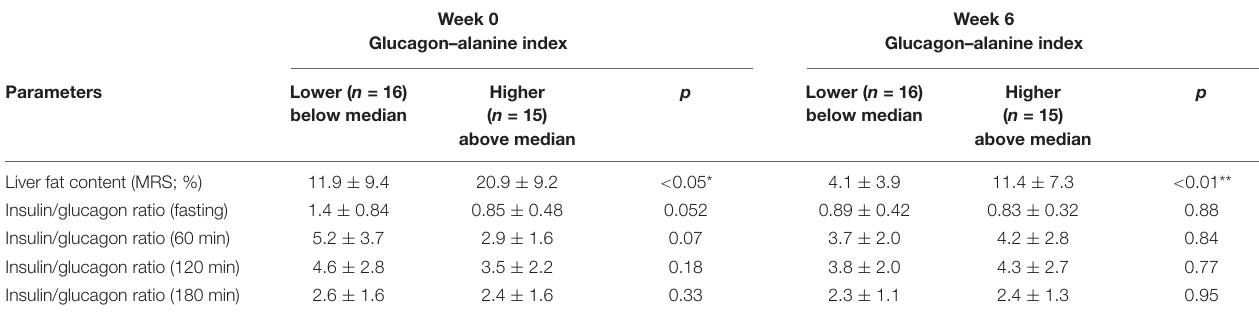
TABLE 3 | Parameters at baseline (Week 0) and after HPD intervention (Week 6) between lower (below median) and higher (above median) basal GCGN–alanine index